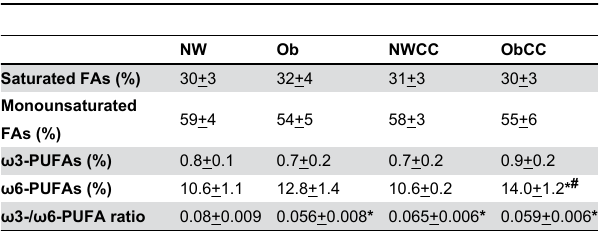
The percentages of saturated and monounsaturated fatty acids (FAs) and ω3- and ω6-polyunsatured fatty acids (PUFAs) were evaluated in visceral adipocytes isolated from normal weight (NW); overweight/obese (Ob); normal weight with colorectal cancer (NWCC), and overweight/obese with colorectal cancer (ObCC) subjects. The data are expressed as means ± SEM. * P<0.05 compared with NW; # P<0.05 compared with